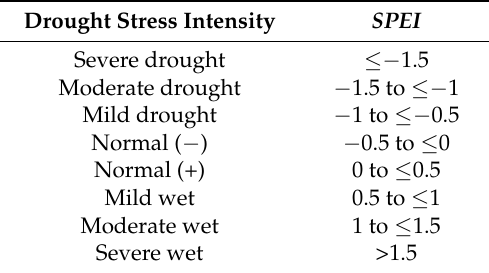
Table 1. Eight grades of drought and their corresponding SPEI